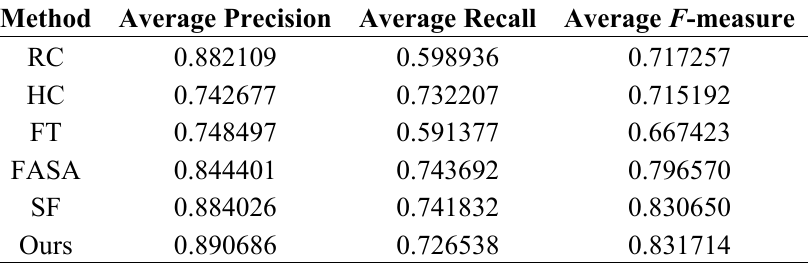
Figure 11. The average Precision, Recall and F -measure based on the adaptive threshold. Table 1. Average precision, recall and F -measure.